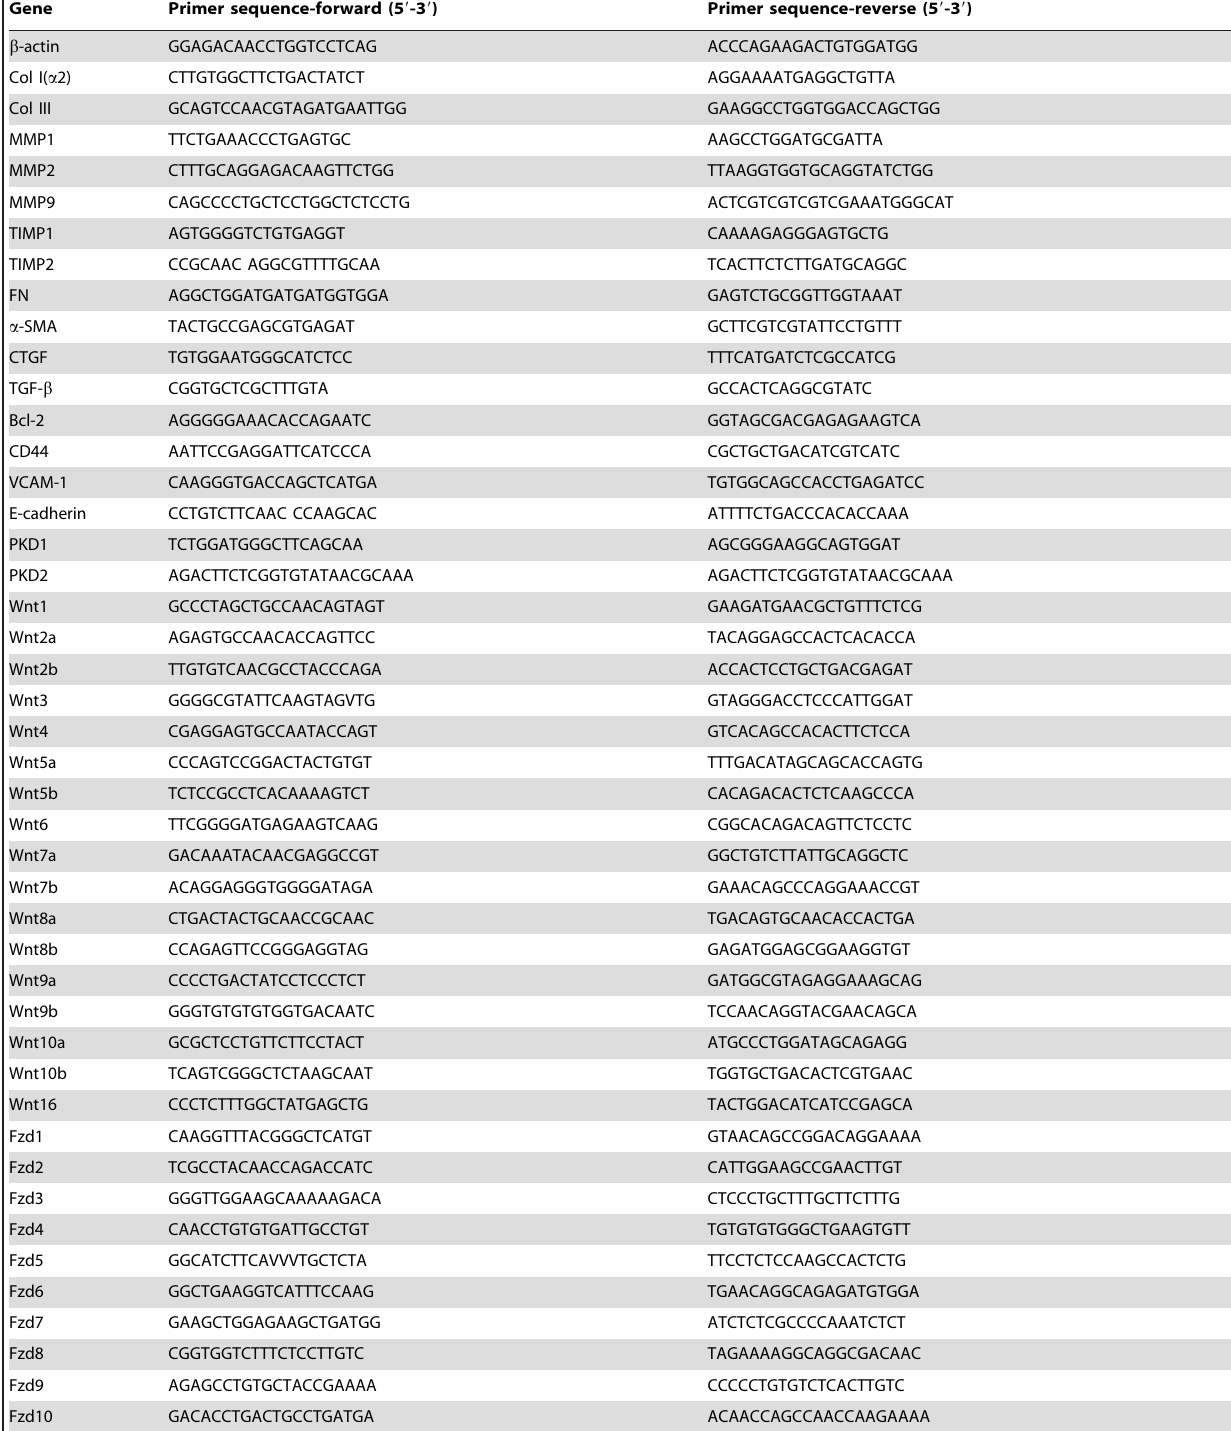
Table 1. Primers for PCR.